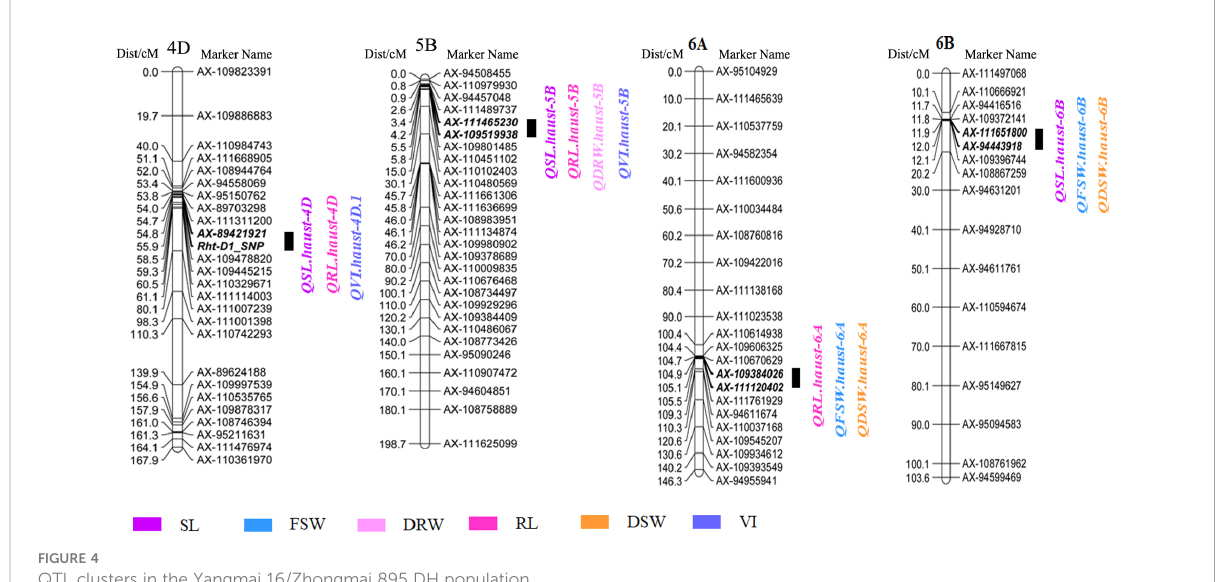
FIGURE 4 QTL clusters in the Yangmai 16/Zhongmai 895 DH population.